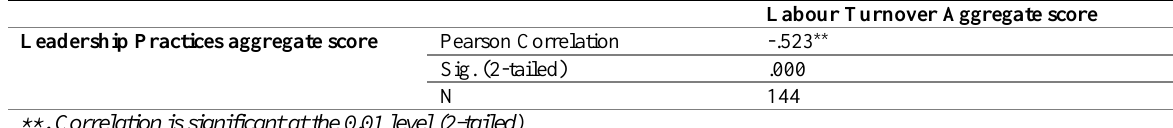
Table 6: Correlation between Leadership Practices and Labour